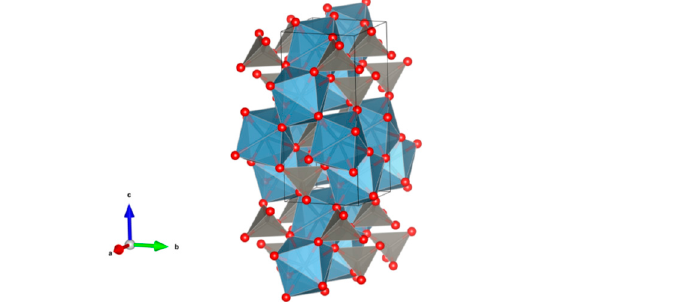
Figure 30. Scheelite. CaWO 4 . Structure tetragonal, Sp. gr. I4 / c. Cations can be Li, Na, K, Rb, Cs, Tl,